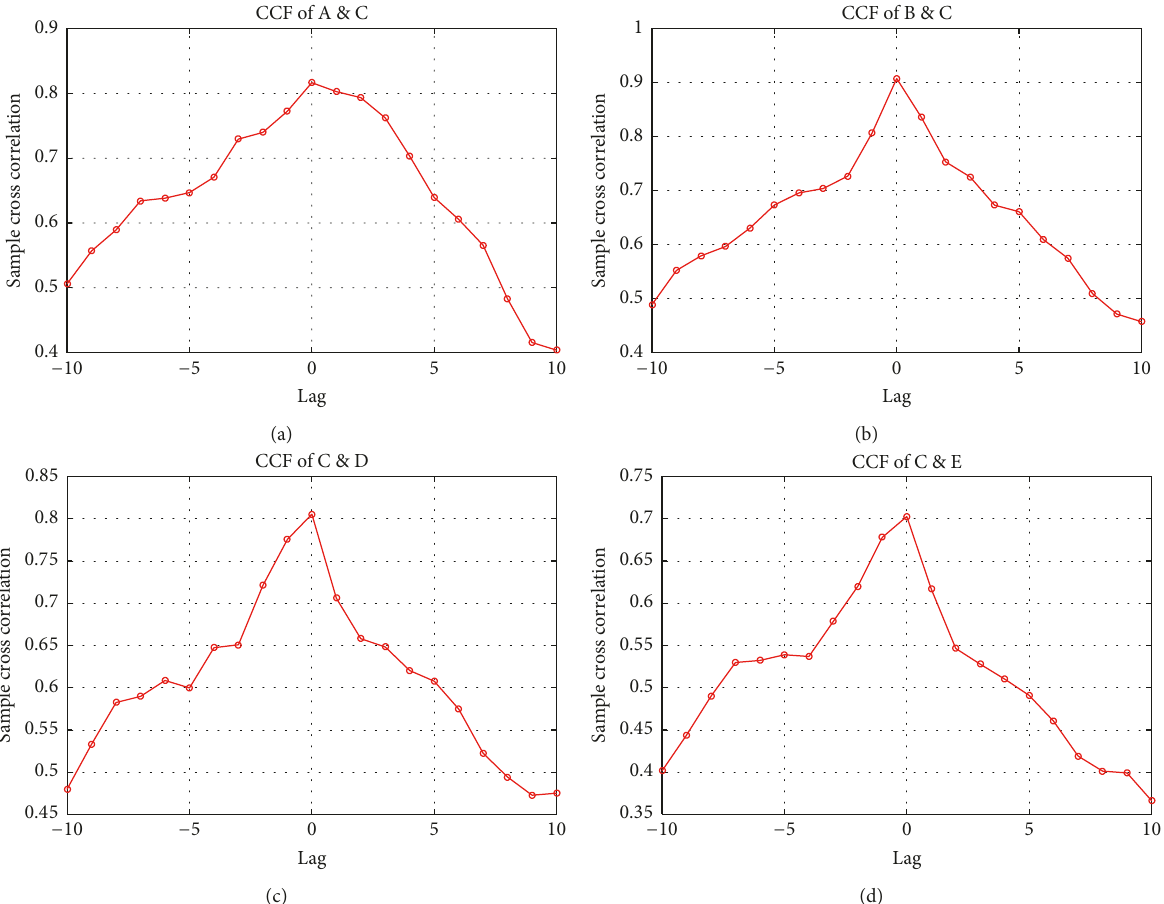
Figure 8: (a) CCF of speed between point A and point C. (b) CCF of speed between point B and Point C. (c) CCF of speed between point C and point D. (d) CCF of speed between point C and point